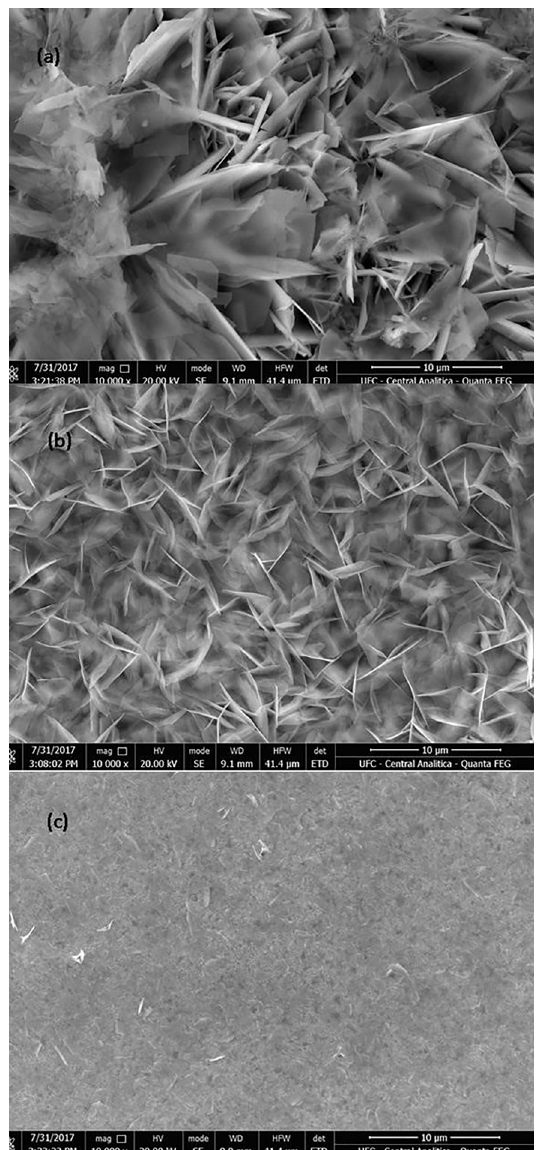
Figure 3. Morphology structures for the three thin ZnO films (a) Film A (b) Film B (c) Film